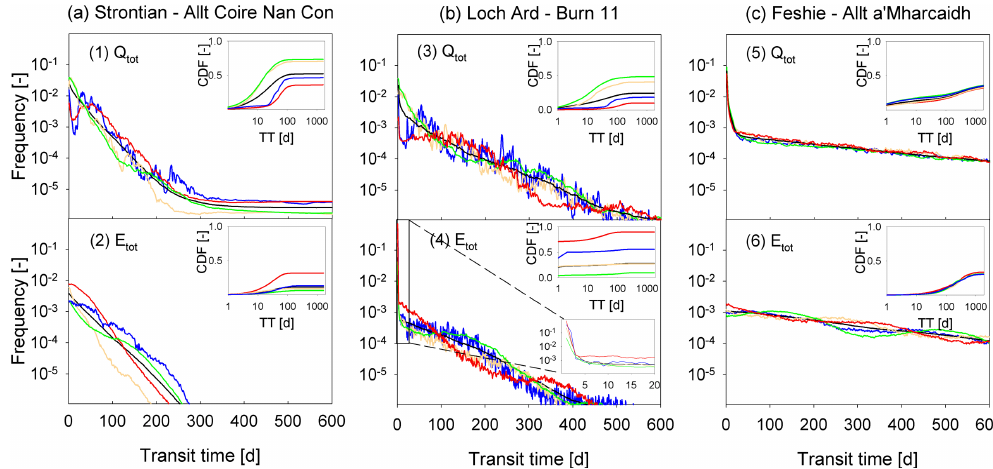
Fig. 9. Temporally averaged, unweighted proxies (i.e. conditional finite measures) for transit time distributions p T for two exit routes (runoff and evaporative fluxes) along which incoming precipitation inputs are routed through the system for the three study catchments for each of the four pre-defined hydrological regimes according to the PM scenarios. The averages were constructed from the median water ages for all time steps within the respective hydrological regime. The color code of the lines is corresponding to the four hydrologic regimes defined in Fig. 5: red (dry), yellow (wetting-up), green (wet) and blue